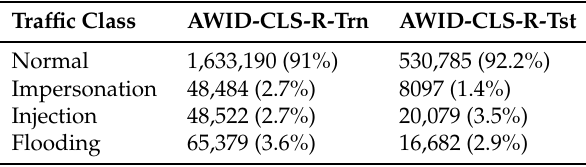
Table 2. Distribution of records in the AWID-CLS-R dataset for each traffic class.